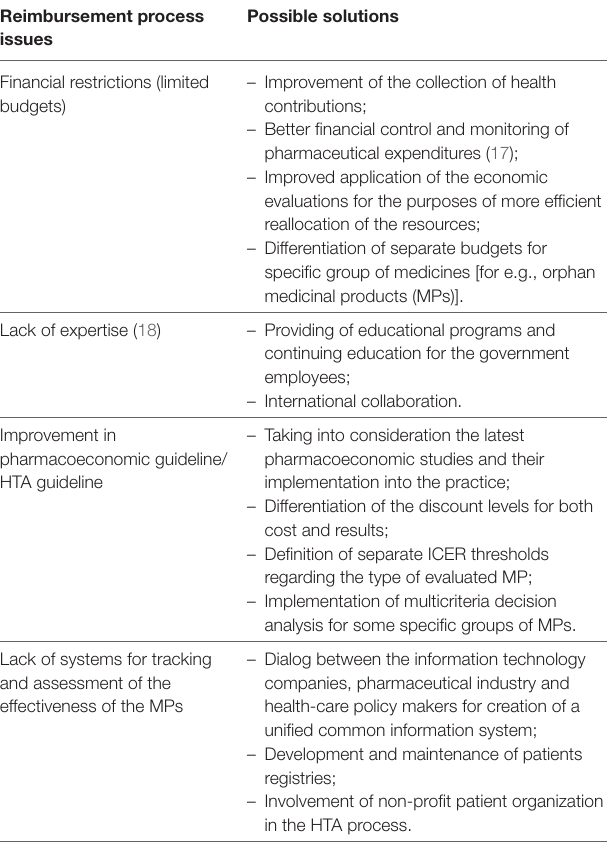
TaBle 2 | Reimbursement issues in low and middle-income countries and possible